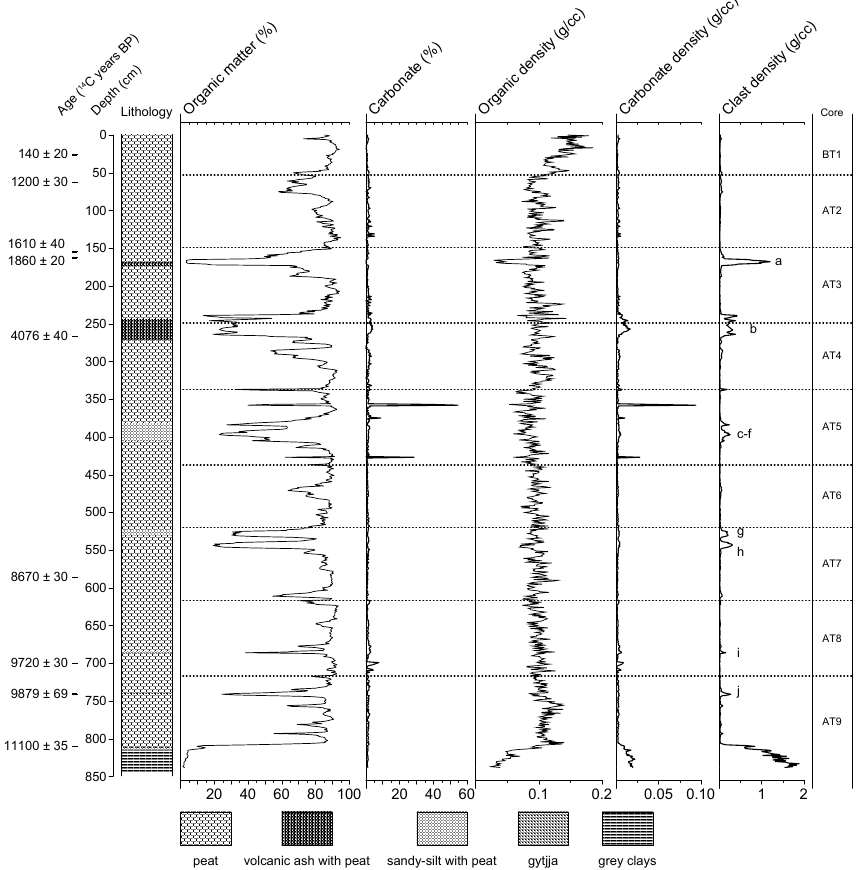
Figure 2. Stratigraphic column of Mallín El Embudo composite core, radiocarbon dates and loss on ignition results. Letters represent clastic layers and dashed horizontal lines indicate the core segment boundaries.